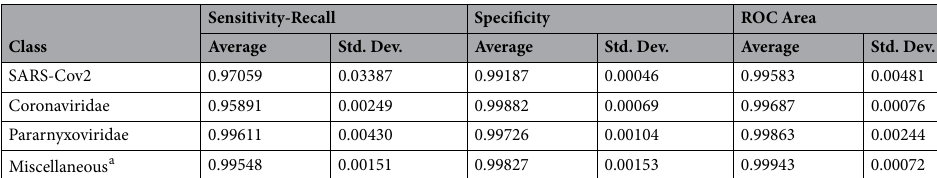
Table 4. Results of Sensitivity, specificity, and ROC area for MLP classifier in the similar symptoms viruses test scenario (results from dataset with 30% overlap). Pneunioviridae, Hantaviridae, Enterovirus, and